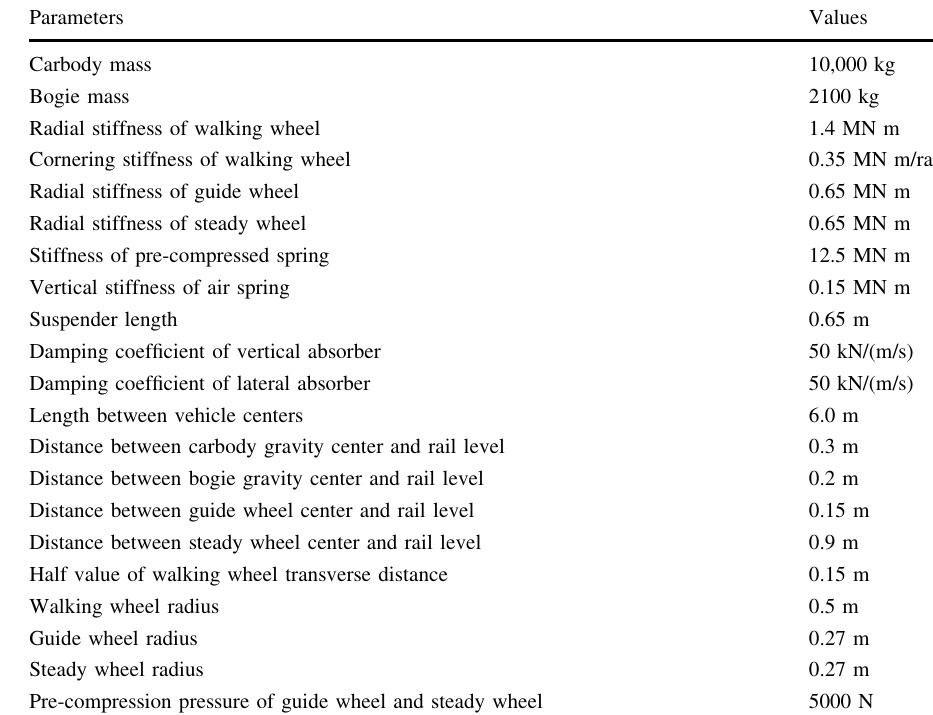
Table 1 Vehicle dynamics